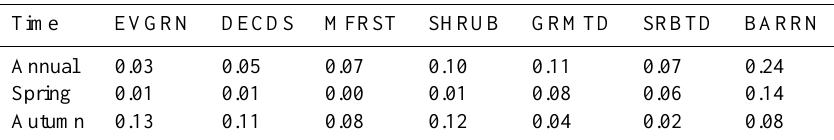
Table A2. R 2 values from the multiple linear regression of SWE vs. factor scores obtained from the principal component analysis (PCA) of TA, MV, and TC. The retained principal components (PC) are determined based on the proportion of explained variance, i.e. only PC accounting for > 10% of the total variance are